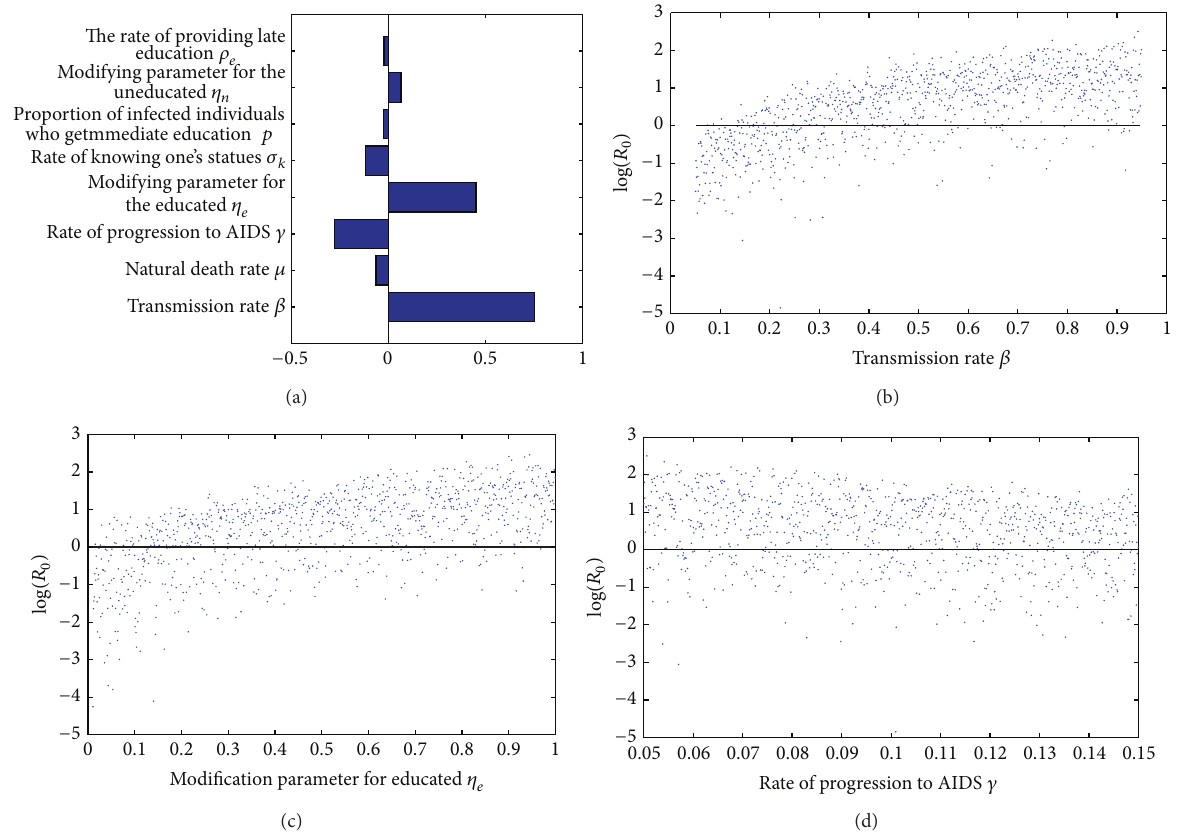
Figure 5: Sensitivity analysis for the testing with limited education model. (a) Partial rank correlation coefficients indicate that transmissibility, the modification parameter for educated individuals and the rate of progress to AIDS have the greatest effect on 𝑅 0 𝑛𝑒 . Parameters with PRCC > 0 will increase 𝑅 0 𝑛𝑒 when they are increased, while parameters with PRCC < 0 will decrease 𝑅 0 𝑛𝑒 when they are increased. (b)–(d) Monte Carlo simulations for 1000 runs drawn from parameter ranges using Latin Hypercube Sampling. If 𝛽 or 𝜂 𝑒 is sufficiently small, then the disease can be